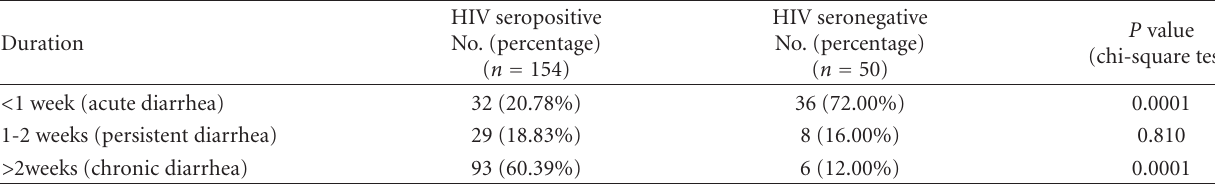
Table 2: Duration of diarrhea in study